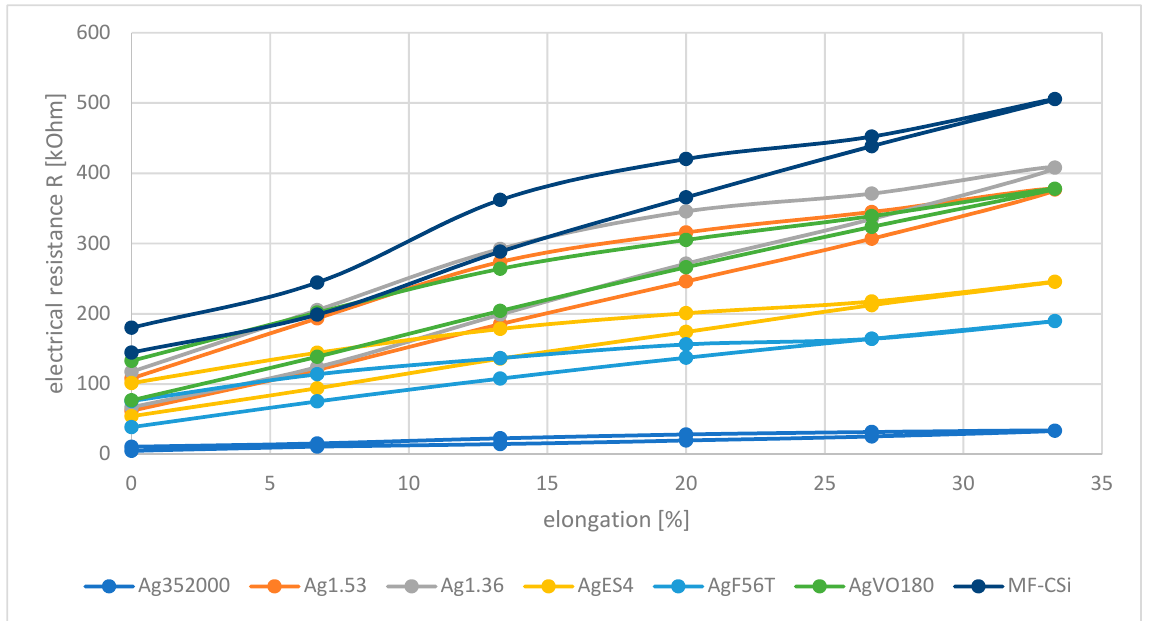
Figure 7. Electrical Resistance R as function of elongation for different silver additives (20%). The lower curves belong to stress, the upper curves belong to relaxation of the monofilament.